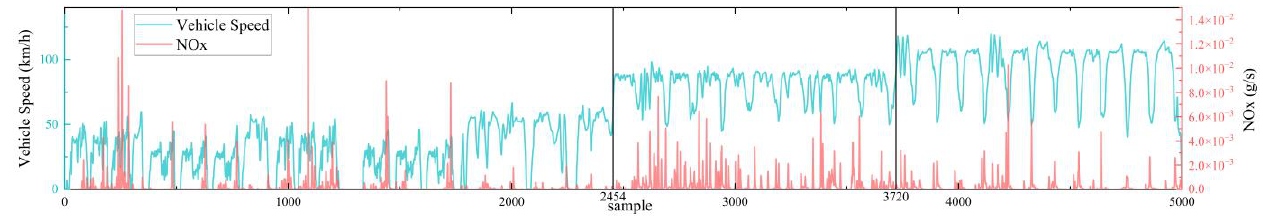
Figure 3. Vehicle speed and corresponding NOx.